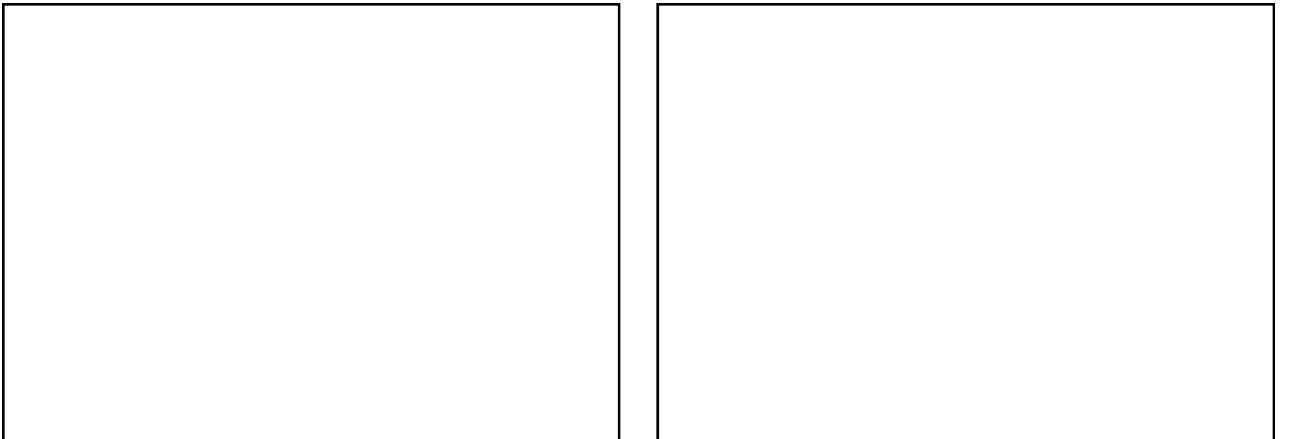
Fig. 2 : Showing features of